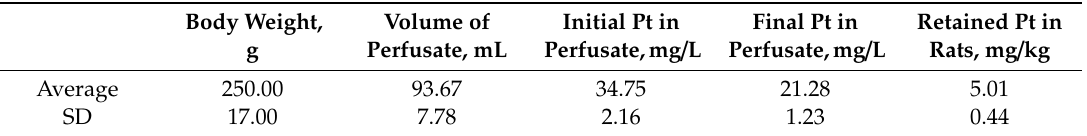
Table 1. Retention of cisplatin-derived Pt in rat body after HIPEC. Calculated as average for 12 rats ( n = 12).